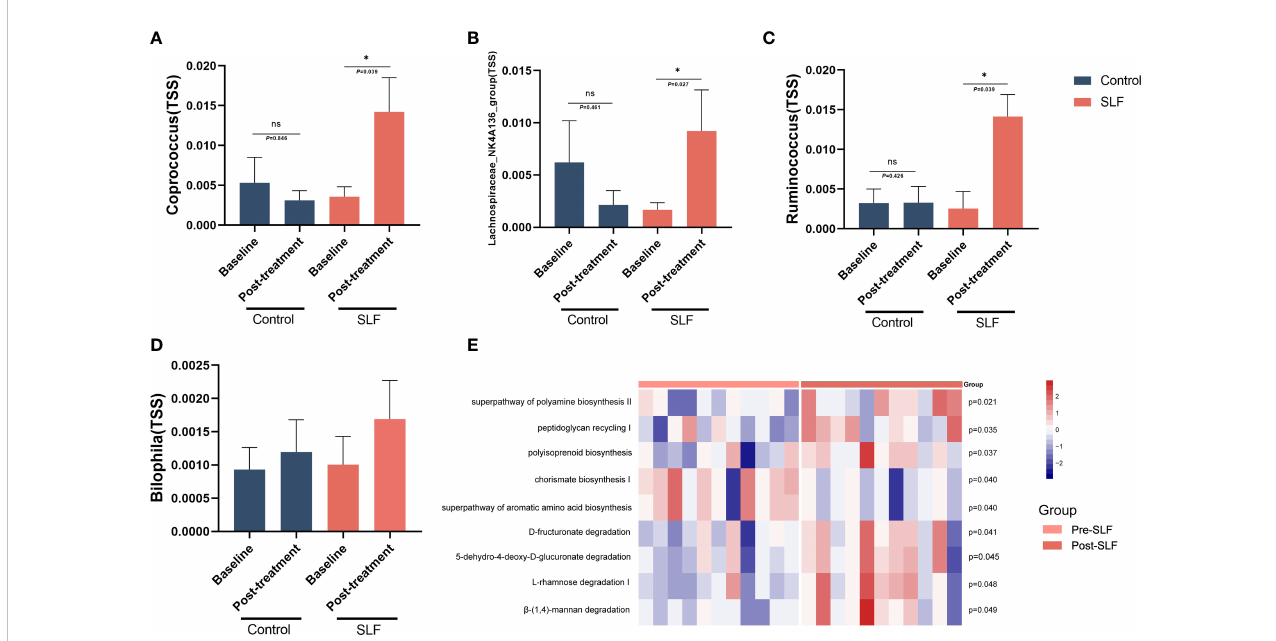
FIGURE 7 SLF exerted its effect by regulating the disturbance of speci fi c intestinal fl ora genera. (A) Comparison of the level of Coprococcus genus in control and SLF group. (B) Comparison of the level of Lachnospiraceae_NK4A136 group genus in control and SLF group. (C) Comparison of the level of Ruminococcus genus in control and SLF group. (D) Comparison of the level of Bilophila genus in control and SLF group. (E) The heatmap of differential metabolic pathways of intestinal fl ora between pre-SLF and post-SLF. TSS: Total-sum normalization. * P <